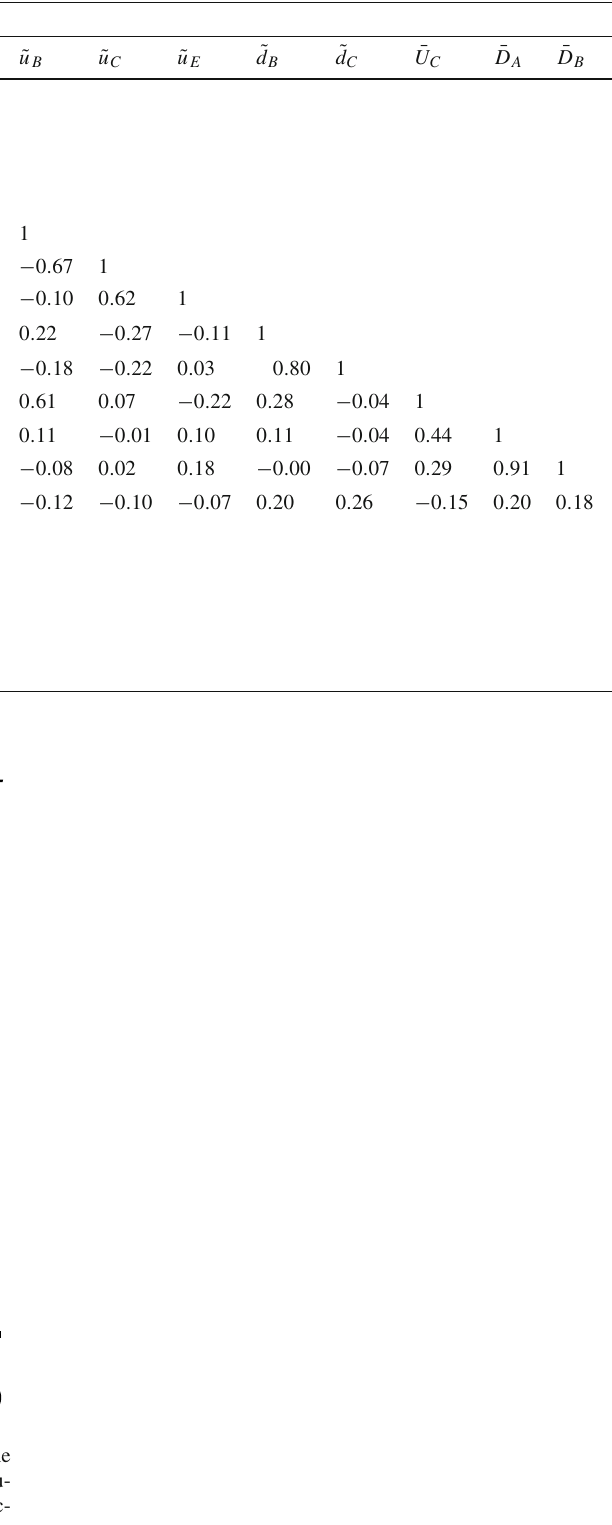
Table 6 Results of the PDF+ α s fit. The columns denote the resulting fit value, its uncertainty and the correlations to the other parameters Results for the PDF+ α s -fit